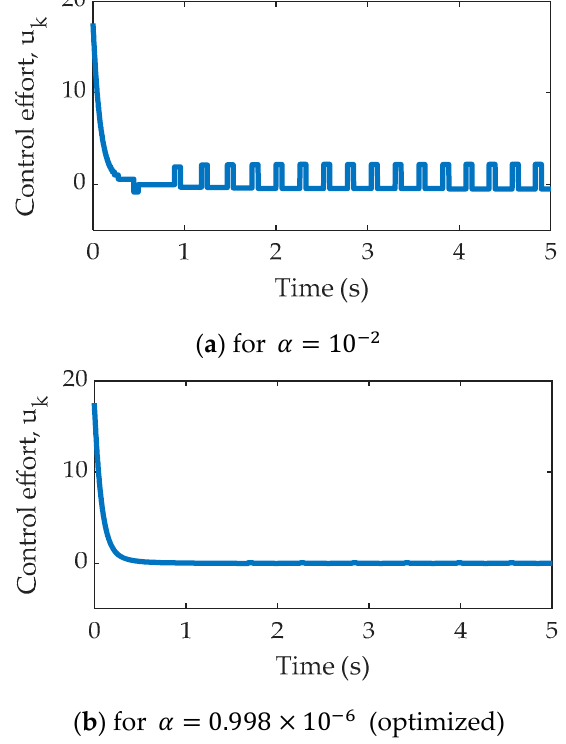
Figure 4. Control effort, u k .